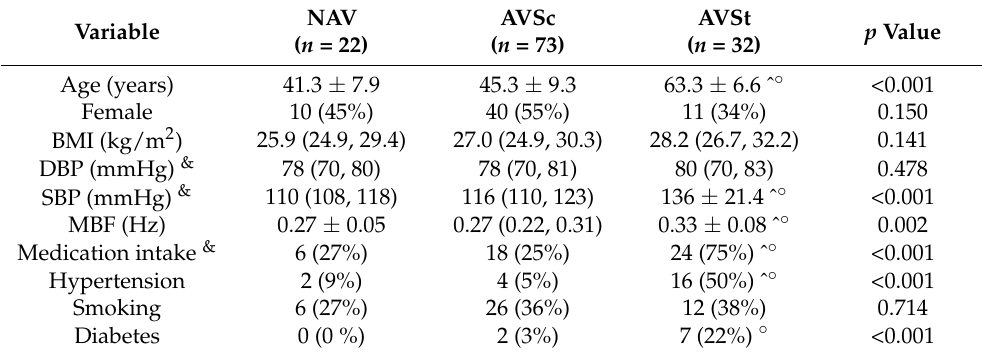
Table 1. Anthropometric and clinical values of participants. Data are shown as absolute value (percentage), mean ± standard deviation, or median (percentile 25, percentile 75).